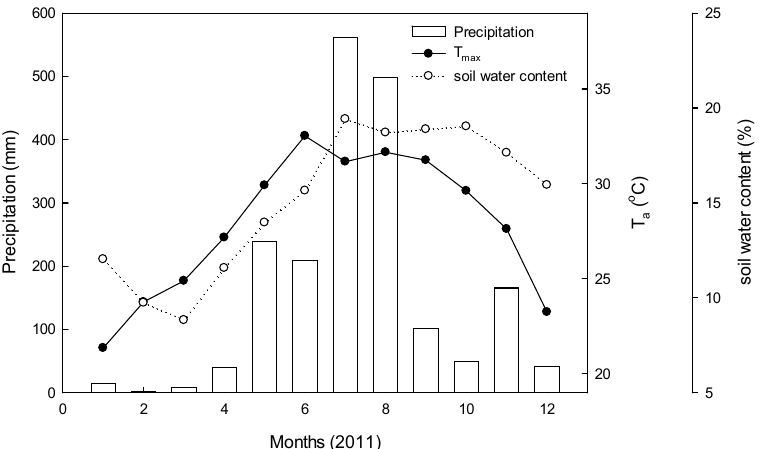
Figure 1. The monthly average maximum temperature (T max ), soil water content, and accumulated precipitation in 2011.